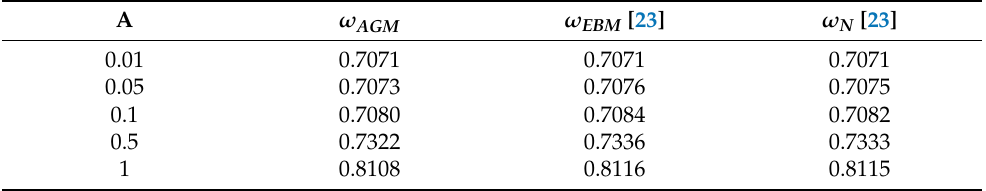
Table 3. Comparison between AGM, EBM and exact numerical solution for mode 1 in Table 1 ( λ = 0.5).